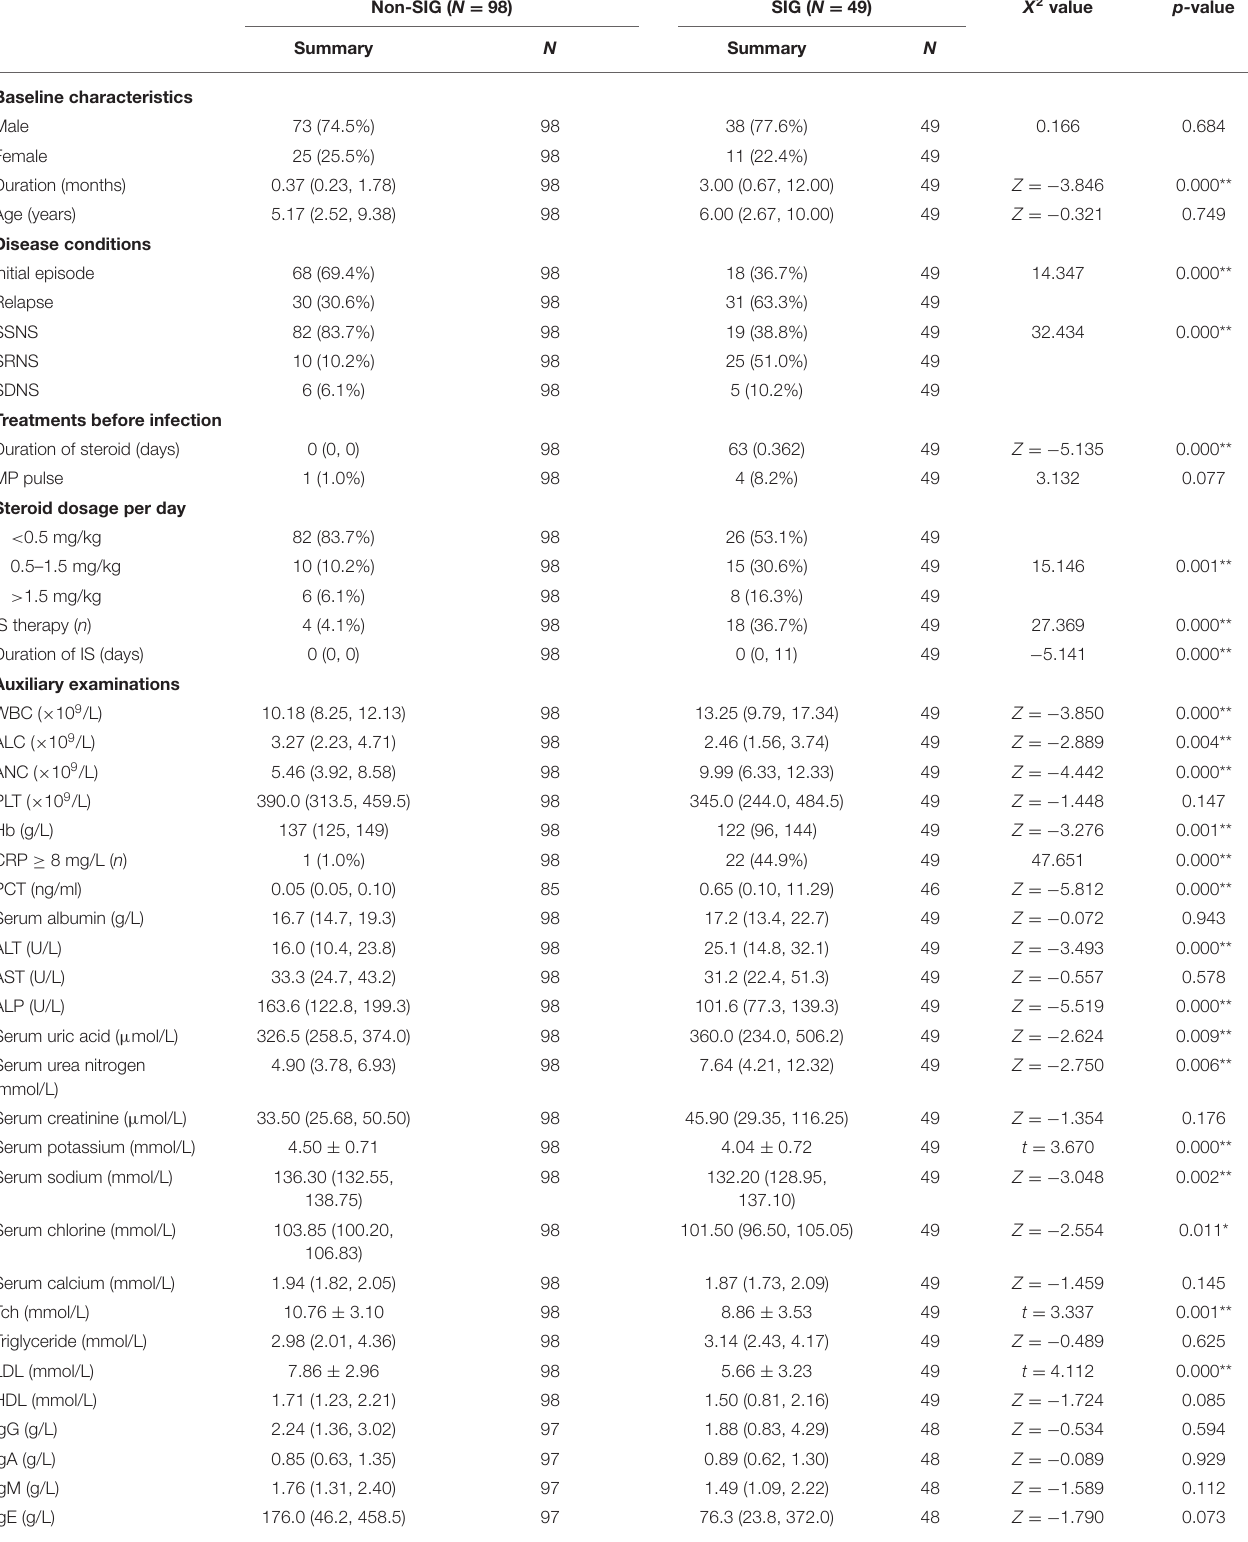
TABLE 3 | Demographic characteristics, laboratory data of children with INS in the severe and non-severe infection group. Non-SIG ( N = 98) SIG ( N = 49) X 2 value p- value Summary N Summary